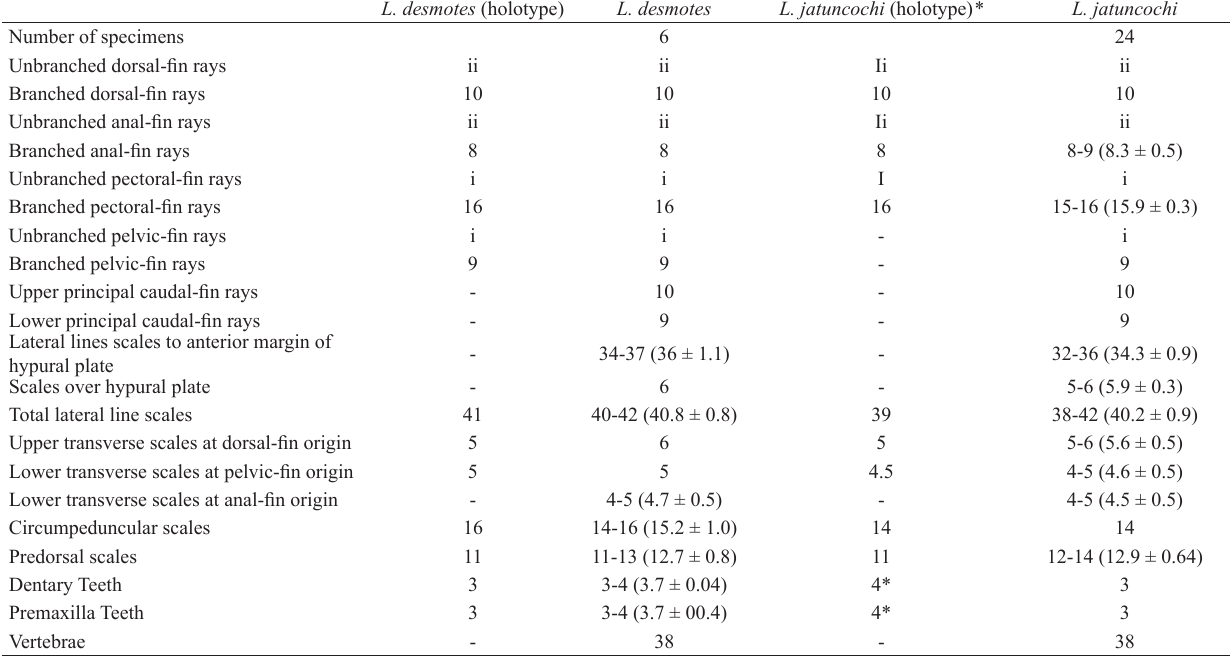
Tab. 4. Meristic counts of Leporinus desmotes and L. jatuncochi summarized as ranges followed by the mean ± 1 standard deviation in parentheses. Single values in a cell indicate invariant counts among the examined specimens for a given species. *Represents data gathered from Ovchynnyk